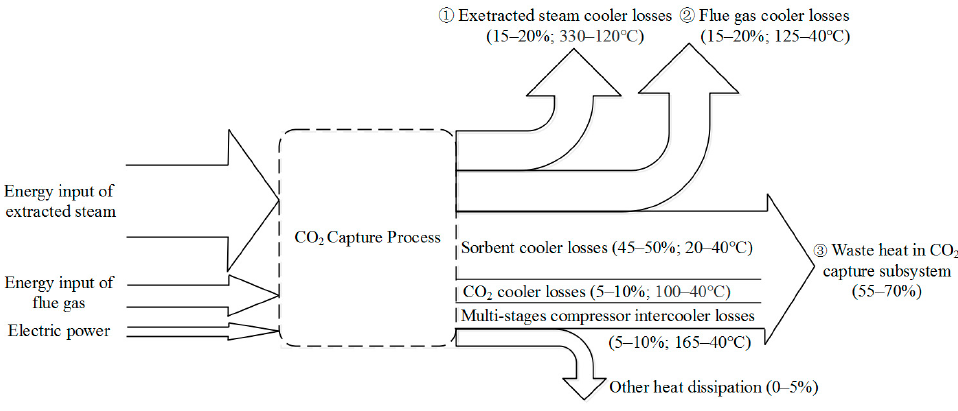
Figure 2. Energy flow schematic of a MEA-based CO 2 capture process.